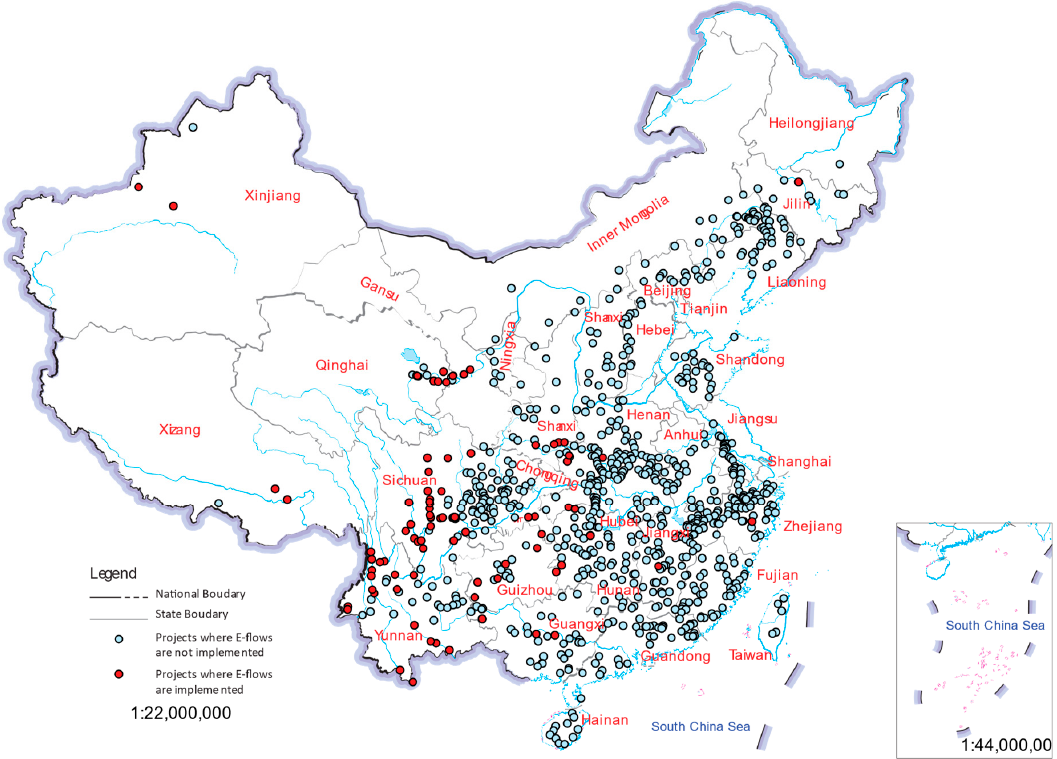
Figure 1. Distribution map of hydropower and water conservancy projects approved by the Ministry of Environment Protection (MEP).